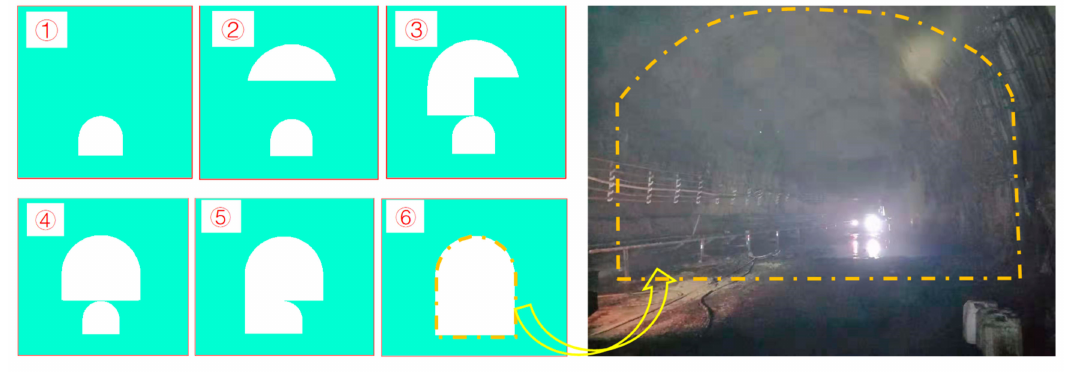
Figure 5. Chamber expansion